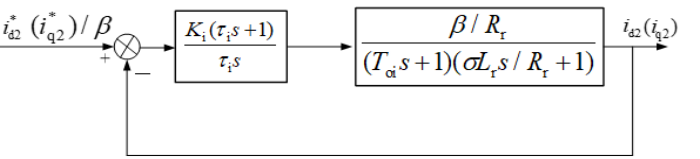
Figure 8. Simplified dynamic structure of the rotor’s current loop of the DFIG. * means the refer- ence value.